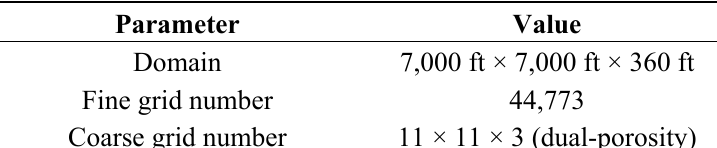
Figure 9. Case 2 model ( a ) model overview; ( b ) DFM grid. Table 3. Model parameters of case 2.